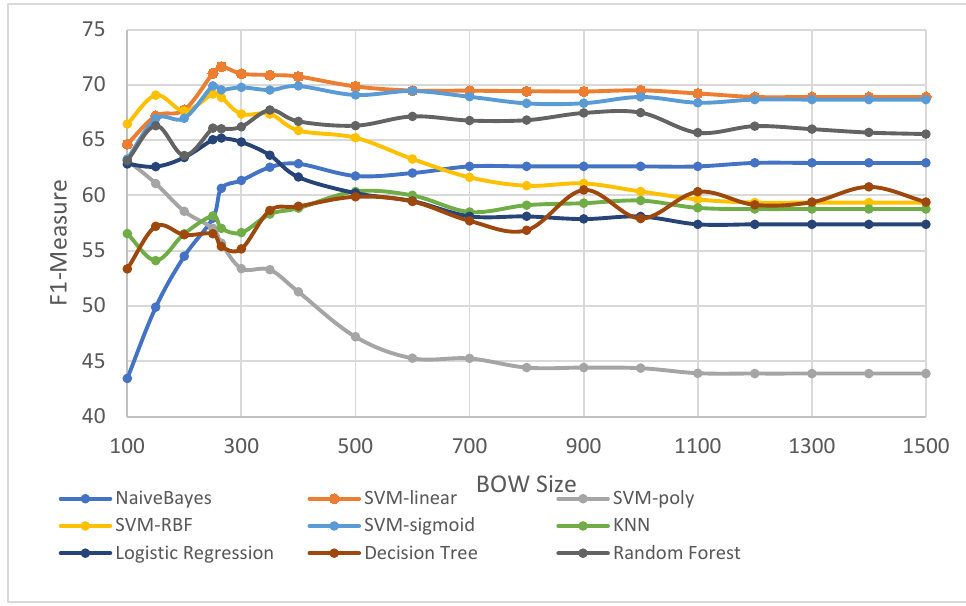
Figure 6. Effect of BOW size in classification for the selected machine learning algorithms. The F1 measure values obtained for varying BOW size using SVM linear kernel are plotted in Figure 7. The vertical axis represents the F1 measure, while the horizontal value shows the BOW size. From the figure, we can conclude that the BOW size of 265 seems to be optimal. BOW sizes greater than 265 do not seem to have a further positive impact on the accuracy of the ML algorithm.